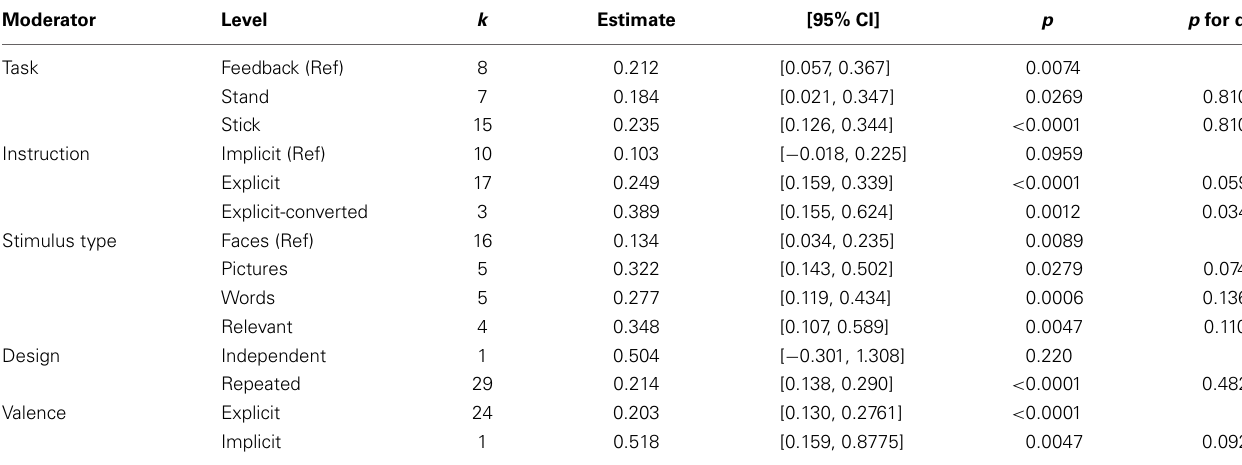
Table 3 | Results of moderator analyses of negative